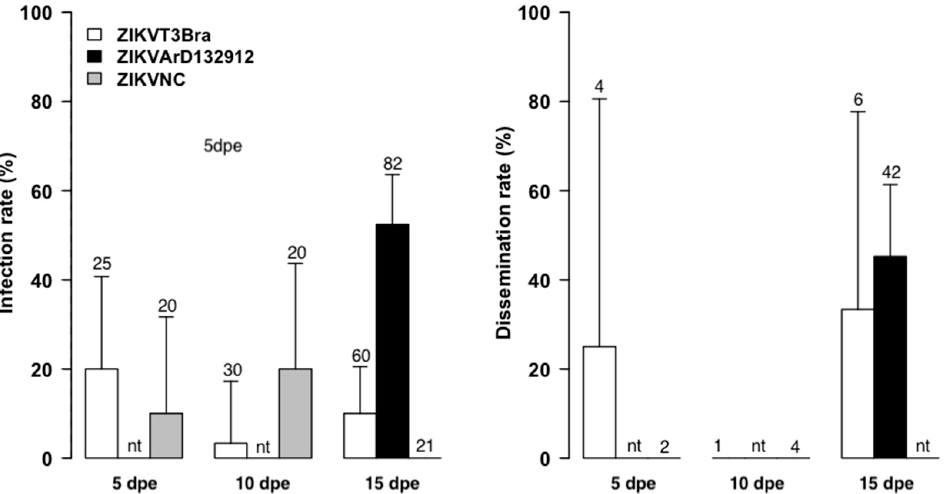
Figure 1. Infection and Dissemination Rates at 5, 10, and 15 dpe for Ae. aegypti from Senegal orally exposed to 10 4 , 10 6 and 10 6 PFU/mL of ZIKV strains isolated from Brazil (ZIKVT3FBra), New Caledonia (ZIKVNC) and Senegal (ZIKV132912), respectively. Values above each column mean the total number tested, nt = not tested.